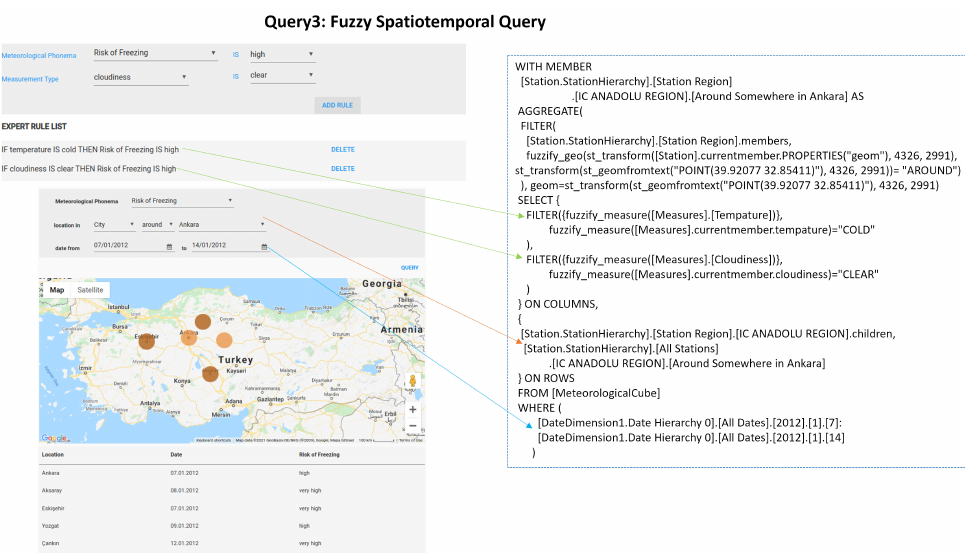
Figure 15. Fuzzy spatiotemporal